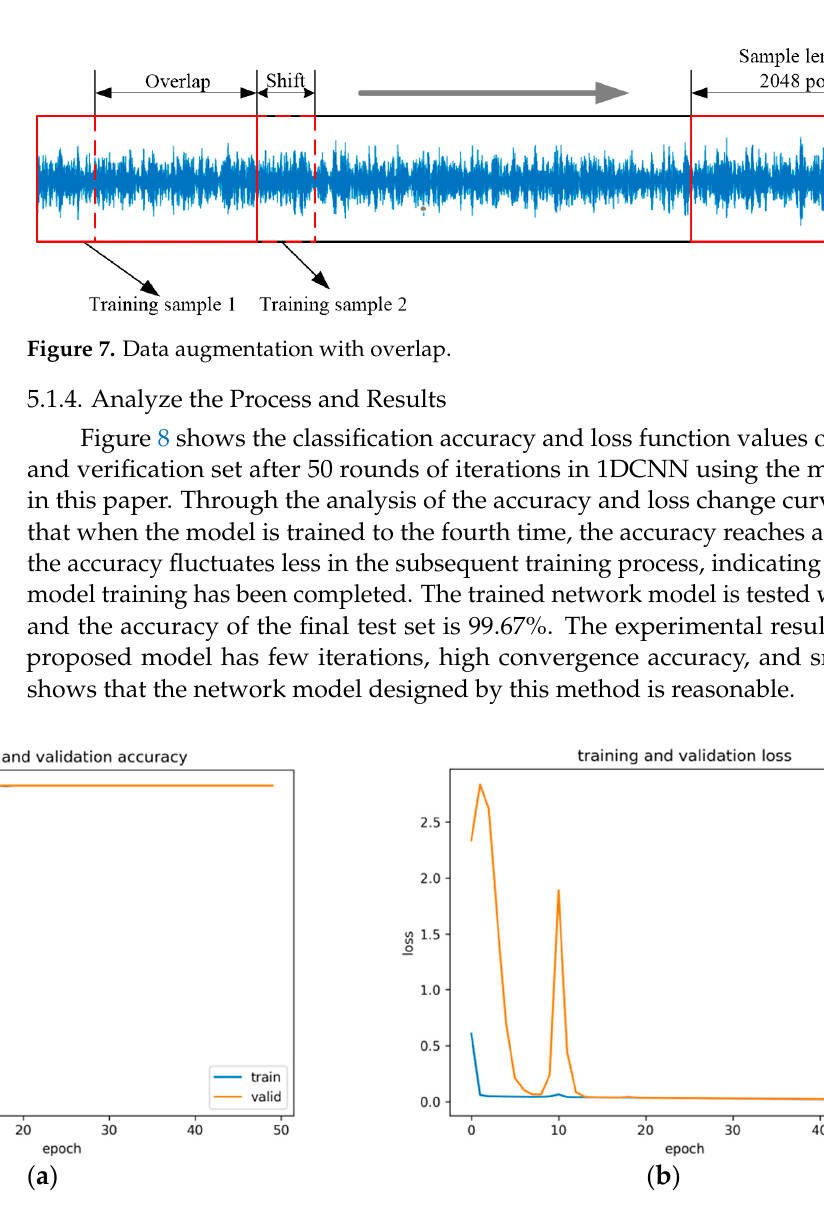
Figure 8. ( a ) Accuracy of the SR-1DCNN model; ( b ) Loss of the SR-1DCNN model.